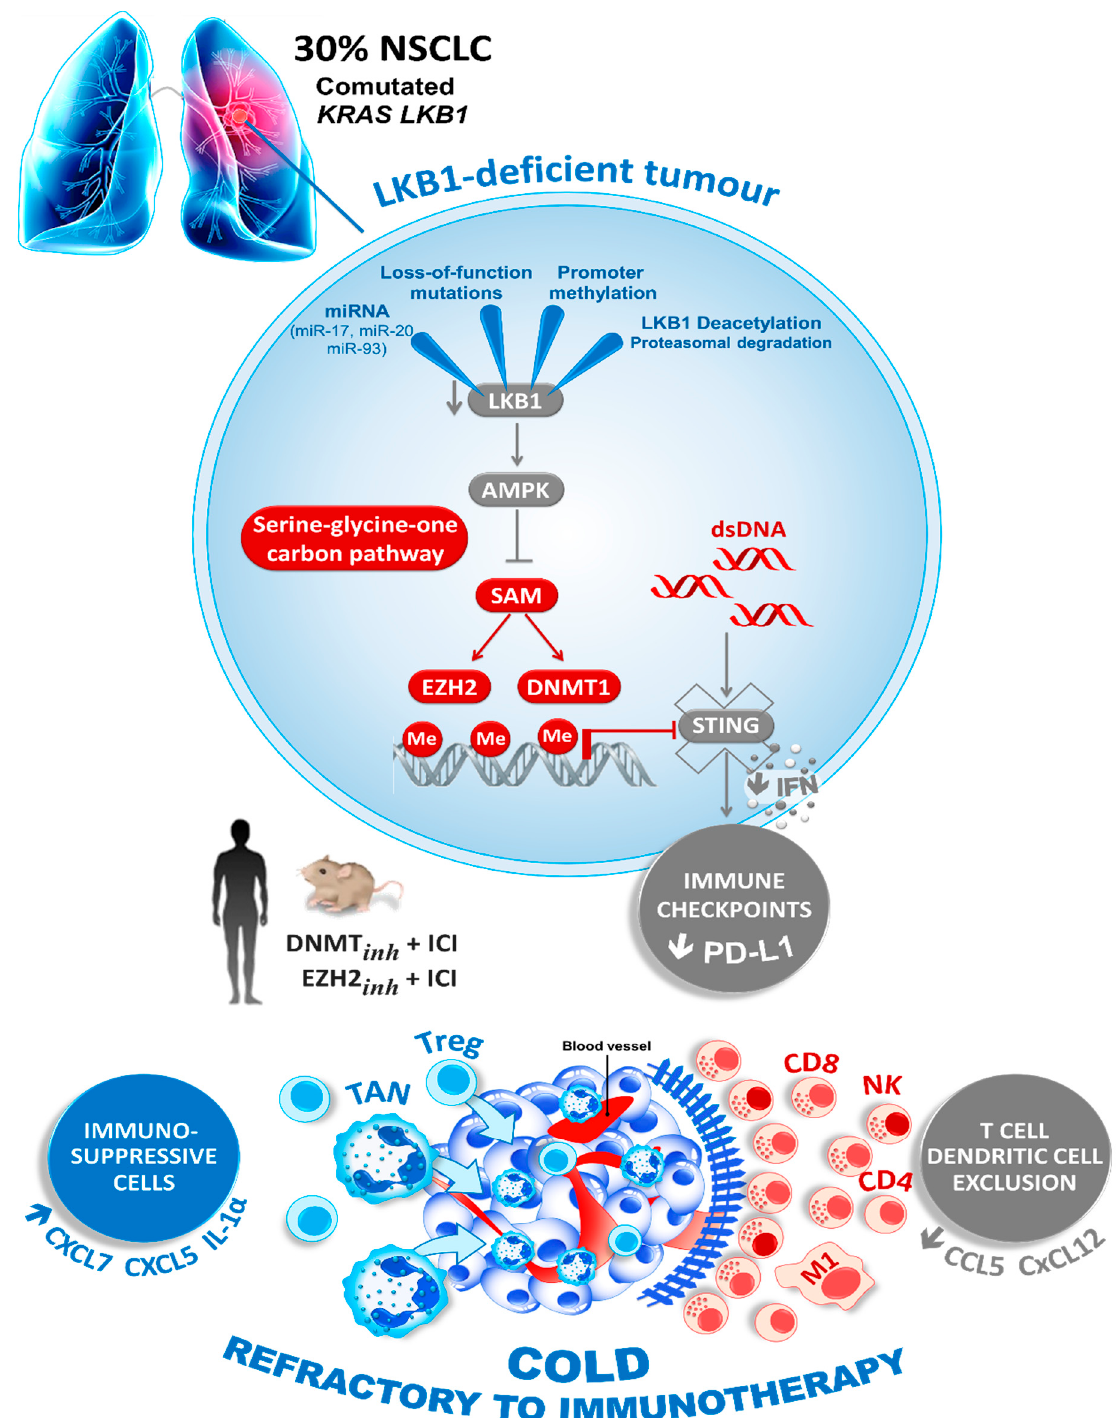
Figure 2. Loss of LKB1 drives the tumor immune escape. The loss of LKB1, the second most commonly altered tumor suppressor in NSCLC, promotes the production of SAM, a substrate for the DNA and histone methyltransferases DNMT1, EZH2 and other epigenetic silencing enzymes. This downregulates the expression of STING, impairing dsDNA sensing, and thereby the expression of immune checkpoint regulating proteins like PD-L1 and T cell chemokines. Therefore, the LKB1-deficient tumors are characterized by a so-called “cold” immunosuppressive tumor microenvironment (blue), which shows the striking infiltration of immunosuppressive cells (TAN; tumor-associated neutrophil; Treg, T lymphocyte regulator, blue) and the exclusion of inflamed immune cells (CD8 T cells, NK, CD4 T cells and M1; Macrophage type 1, red). Epigenetic therapies that reactivate LKB1 or the STING pathway may boost an anticancer immune response in LKB1-deficient cancers with the resistance to immune-checkpoint blockade (ICI, immune checkpoint inhibitor).